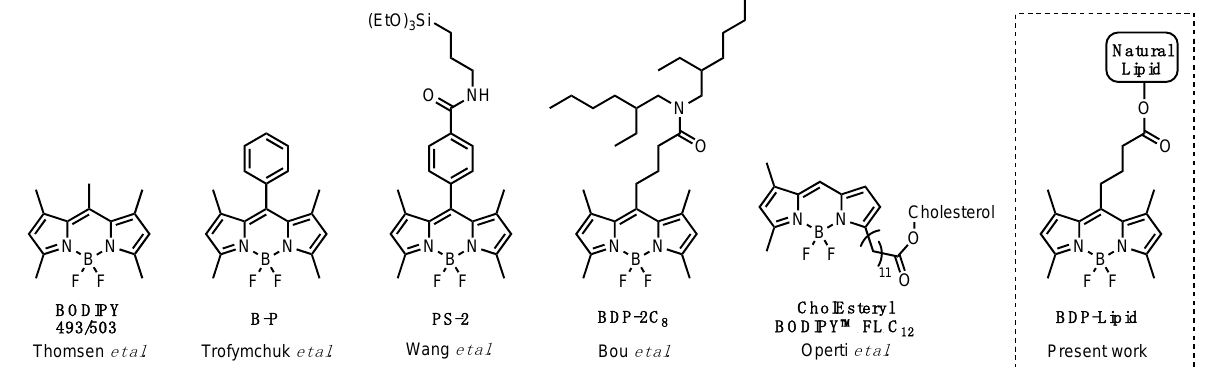
Figure 1. Green emitting BODIPYs used for dye-loaded nanomaterials.